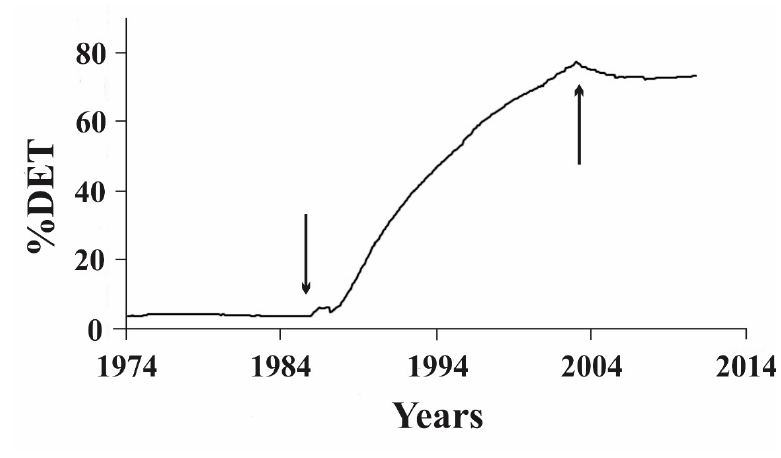
Figure 9. %DET of interevent times sequences (M2.2 threshold) around the Enguri reservoir (R = 100 km) 1974–2017. Note increased determinism in waiting times after 1986.